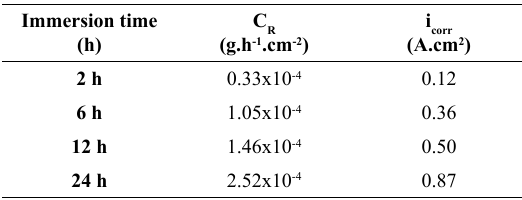
Table 2. Corrosion rates and corrosion current densities calculated from gravimetric experiments for AISI 1020 carbon steel immersed for different times in 0.5 mol.L -1 HCl solution with 1.77 g.L -1 of castor bark powder.